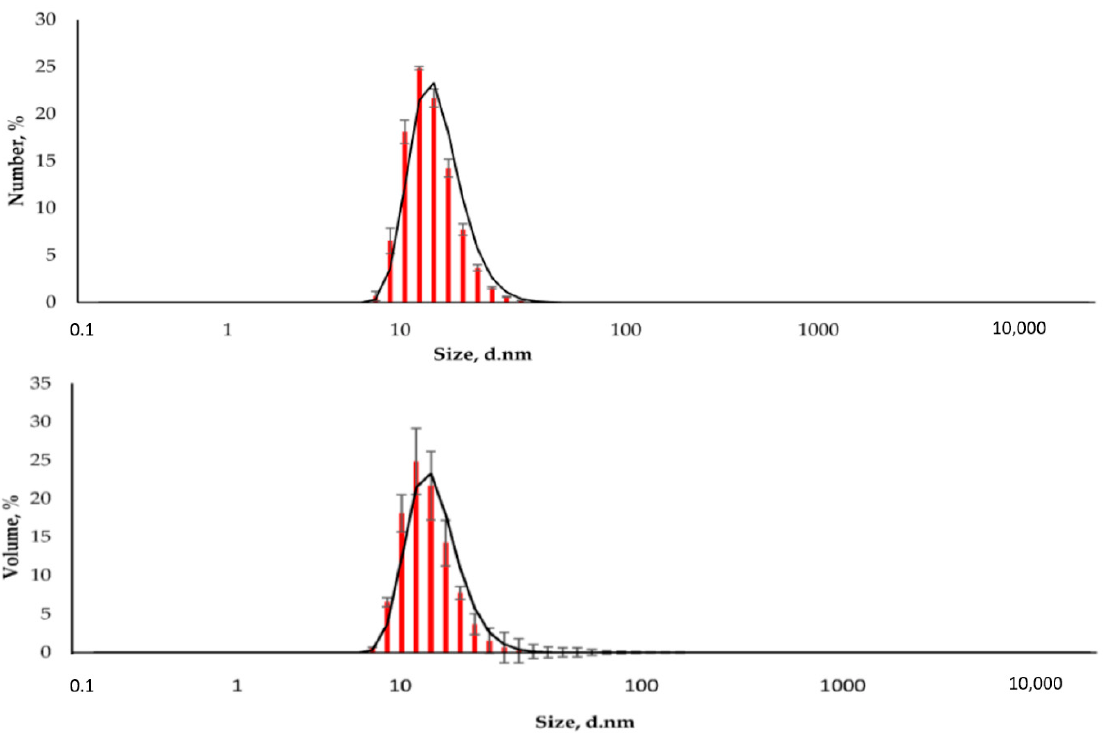
Figure 3. The distribution of the hydrodynamic diameter of the nanoparticles was obtained by DLS (Number and Volume distributions).